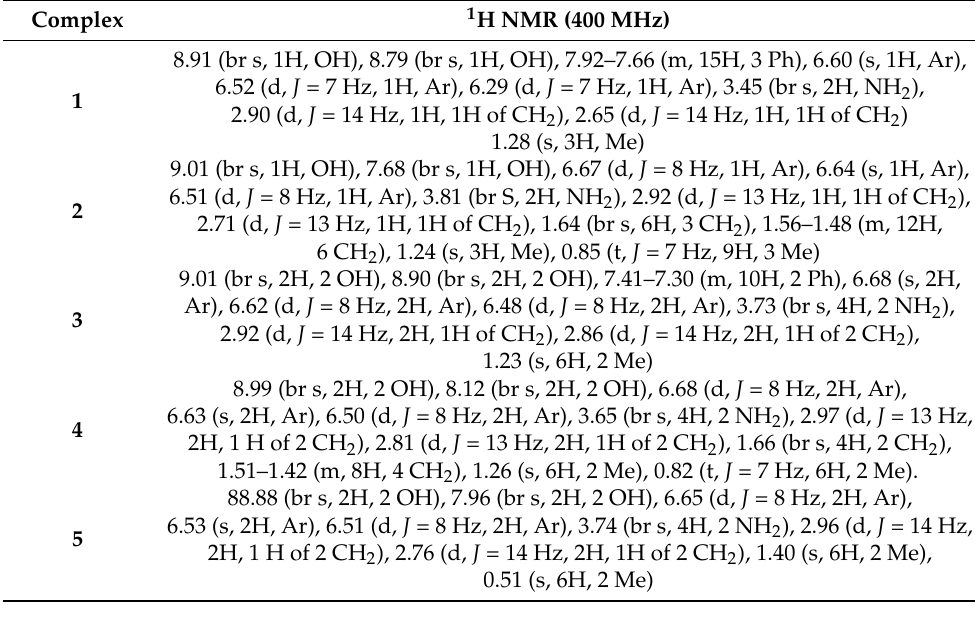
Table 3. 1 H NMR spectral data of 1–5 .